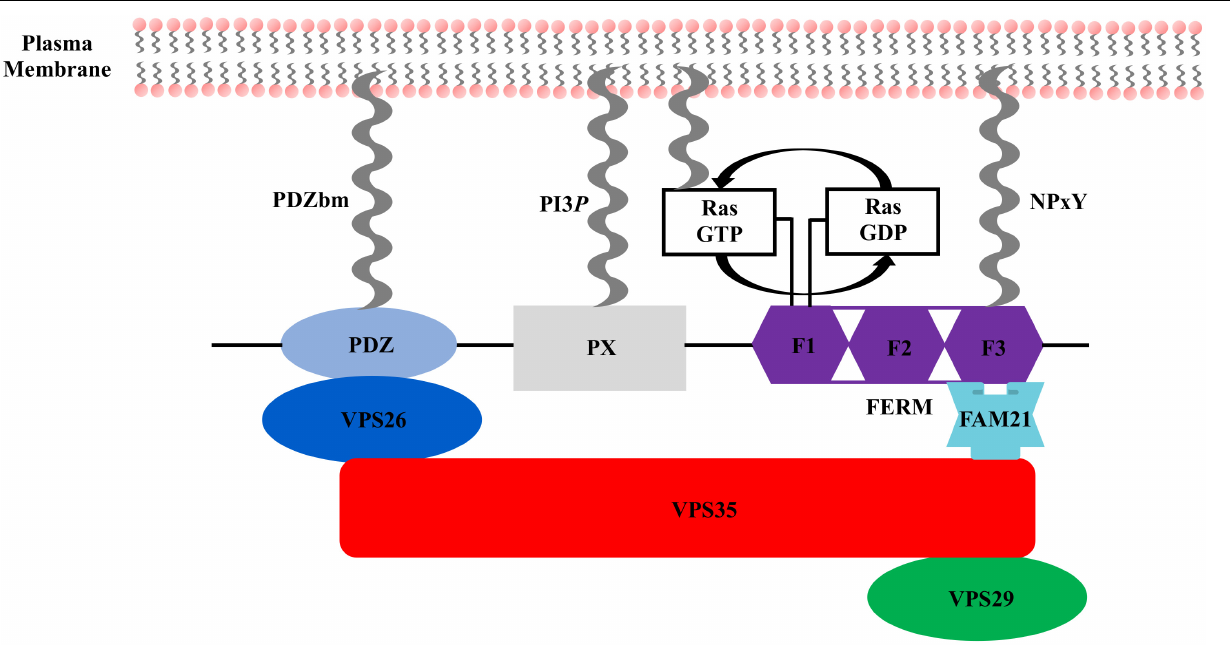
FIGURE 2 | Sorting nexin 27 (SNX27) domain architecture. SNX27 contains a modular architecture with three established domains: the N-terminal PDZ domain (light blue), middle PX domain (gray), and C-terminal FERM domain (purple), which is divided into F1, F2, and F3 sub-domains. Key interactions in the SNX27/retromer pathway are indicated. VPS26 (dark blue) binds the PDZ domain. Ras binds the F1 sub-domain, and FAM21 engages both the SNX27 F3 sub-domain and retromer VPS35 subunit. All three SNX27 domains directly engage protein partners embedded in membranes enriched for PI3 P